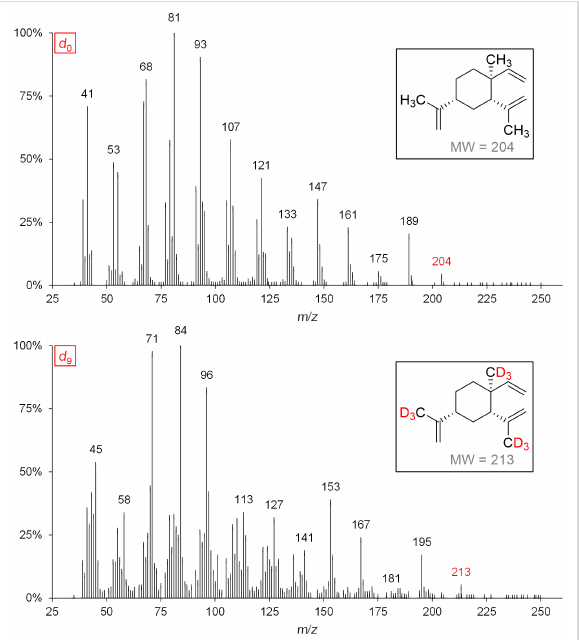
Figure 8: MS spectra and expected labeling patterns of genuine ( d 0 ) and deuterium-labeled ( d 9 ) β -elemene after feeding experiments of grape berry exocarp using d 3